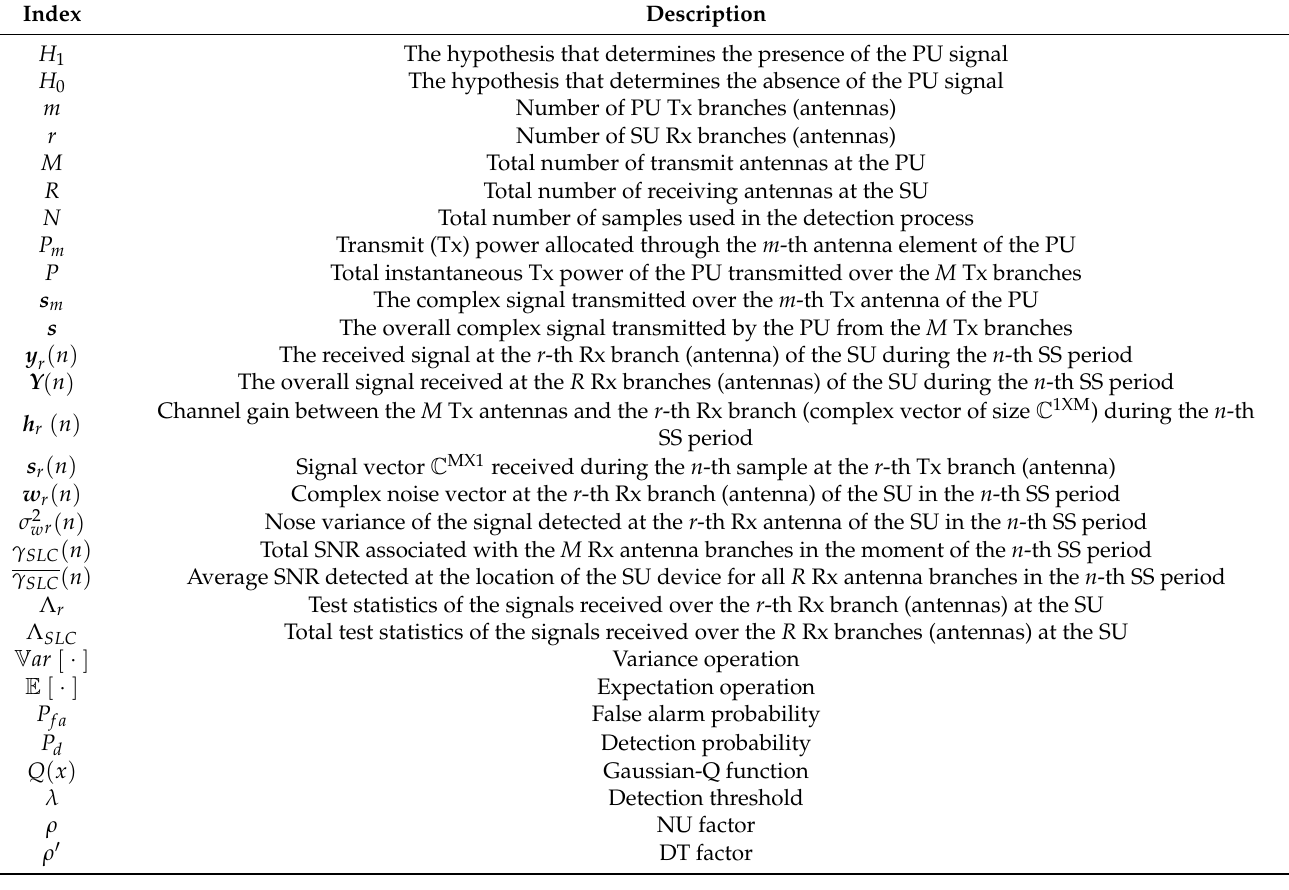
Table 1. Parameters used in the analyses.